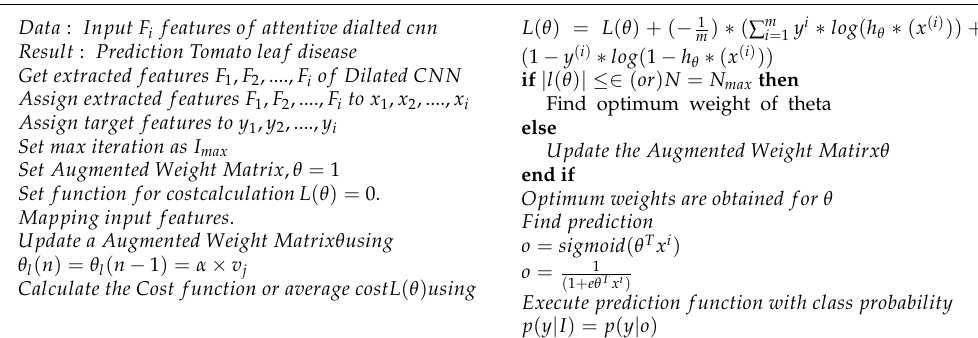
Algorithm 4 Main Classification Algorithm of ADCLR Model Using Logistic